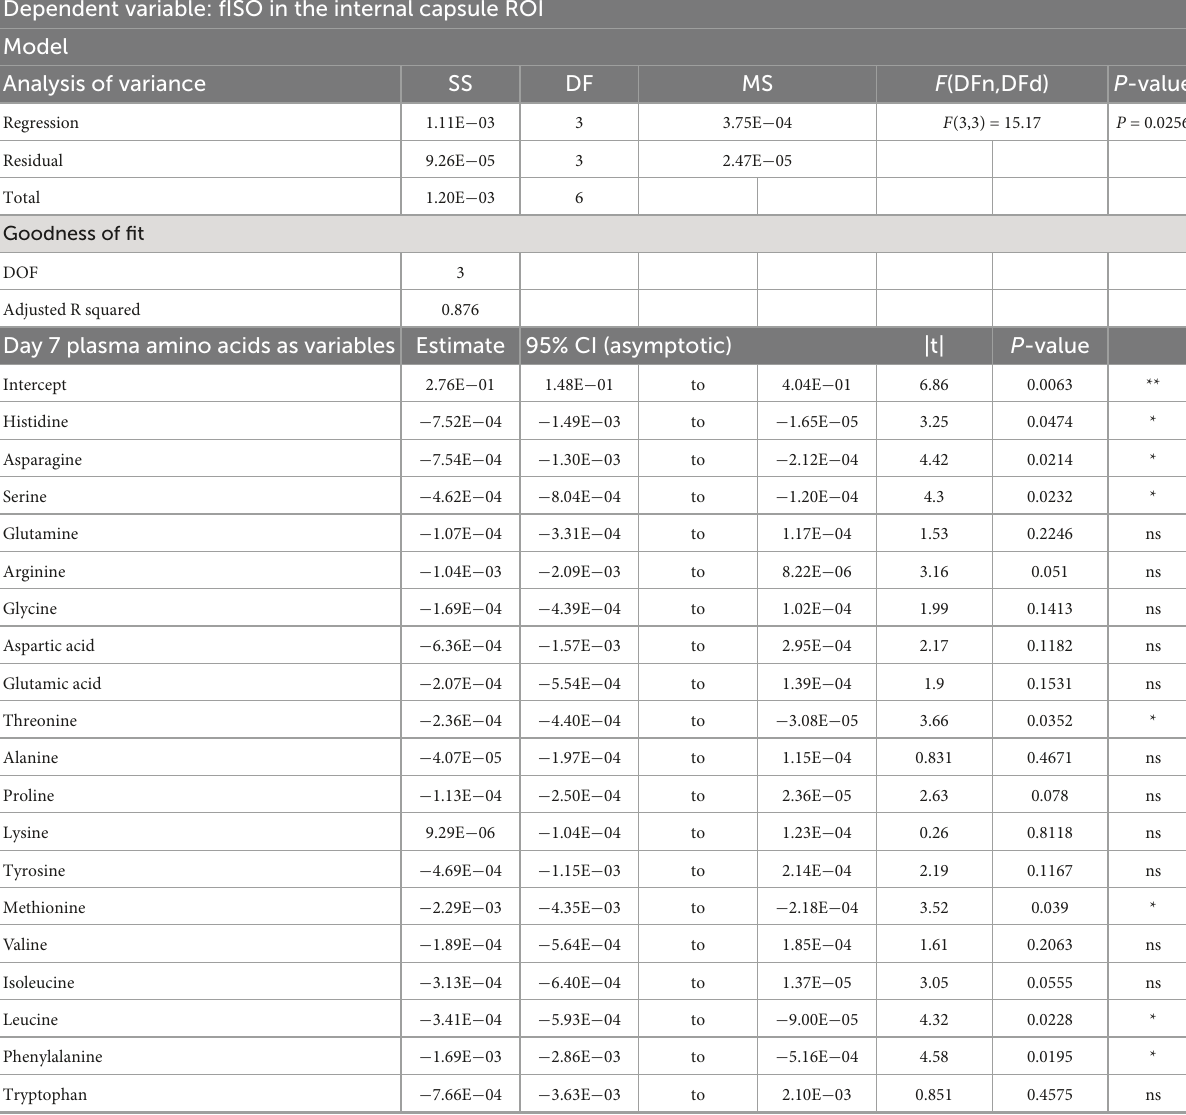
TABLE 4 Result of PCR predicting the fISO quantified from the internal capsule ROI from the plasma amino acid panel at day seven post-injury. Dependent variable: fISO in the internal capsule